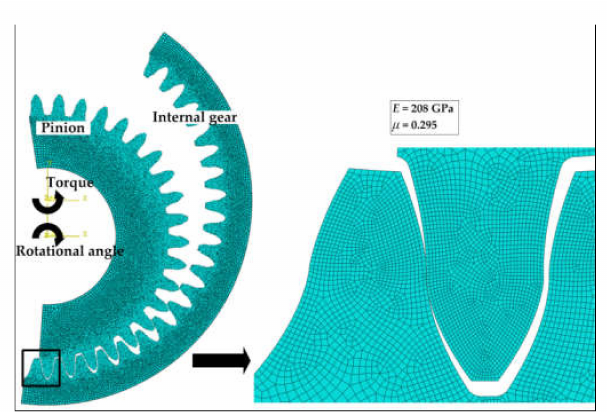
Figure 9. Two-dimensional 20-teeth finite-element model.